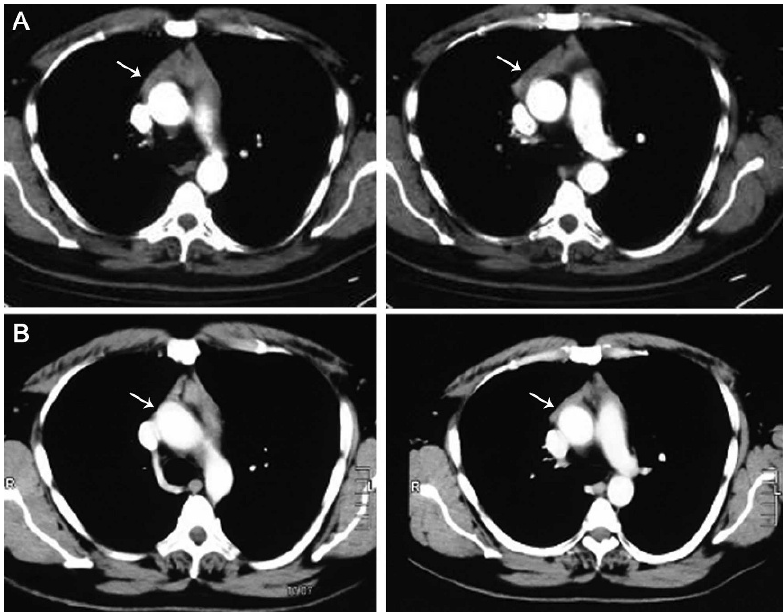
Figure 1 - CT-scan images showing a thymus enlargement before (A) and after (B) treatment for hyperthyroidism due to Graves 9 disease, with remarkable shrinkage of the